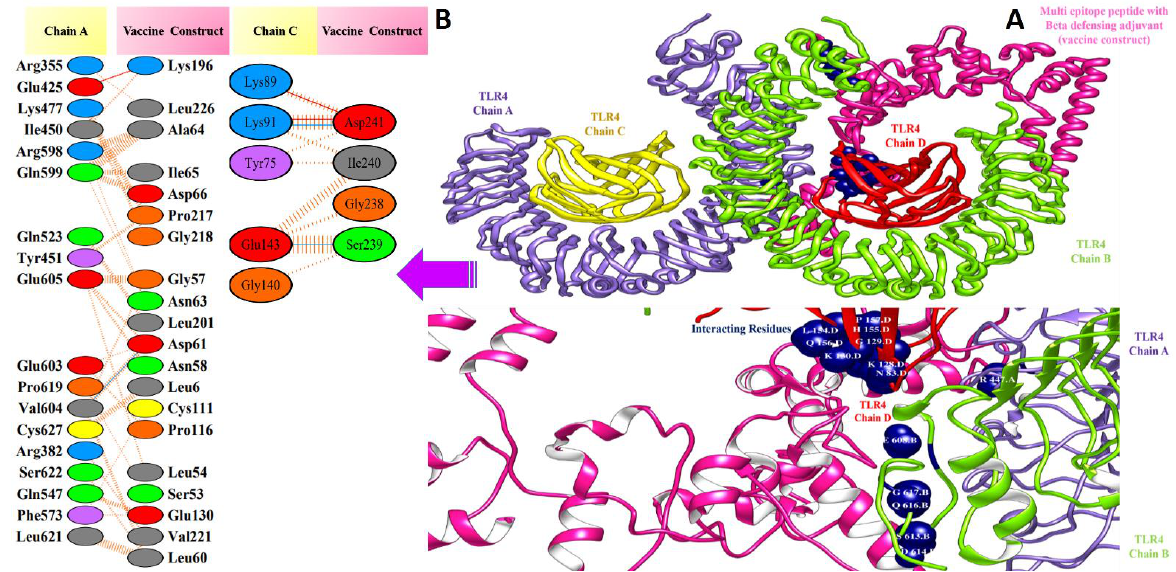
Figure 8. Docked pose of β -defensin vaccine with TLR4: ( A ) every single entity of the complex is self-explanatory. Each chain of the receptor TLR4 is represented in a different colour, i.e., chain A: purple, chain B: green, chain C: yellow, and chain D: dark red, and the designed vaccine construct β -defensin is represented in deep pink; interacting residues between receptor and vaccine are shown in navy blue. ( B ) Residue-residue interaction between vaccine construct and TLR4 chains.